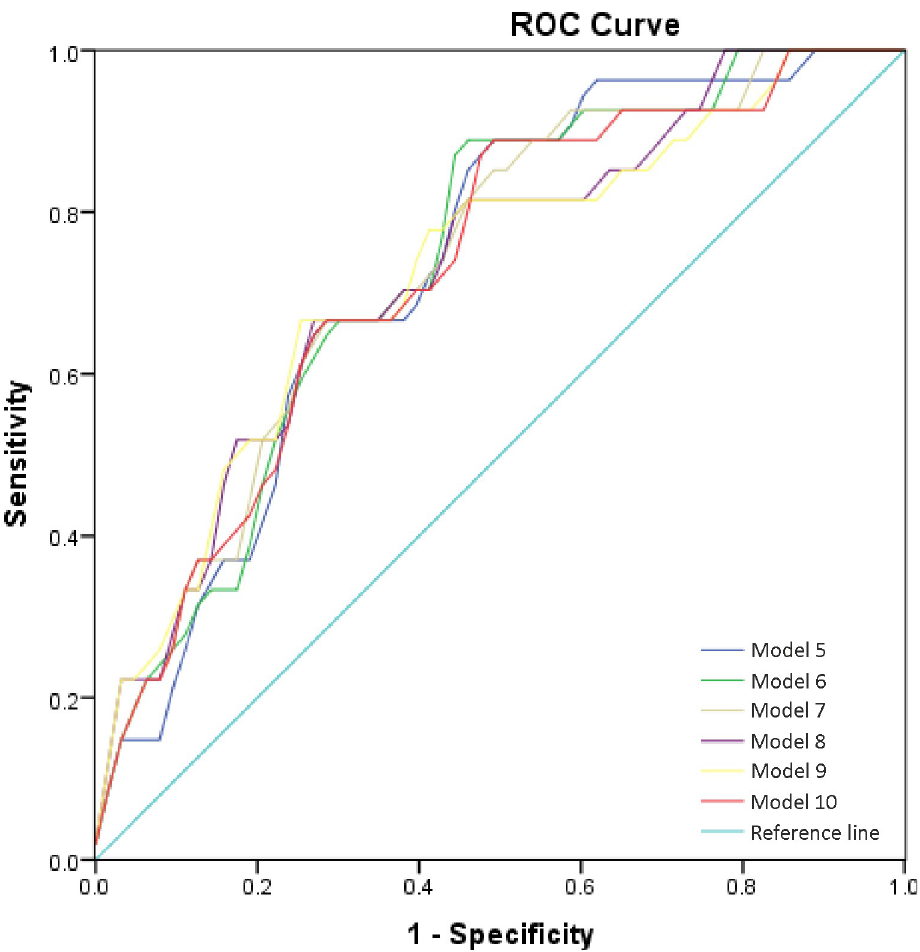
Fig 4. Receiver operating characteristics (ROC) curves for different models calculated from the logistic regression with best AUC. Abbreviations: AUC: Area Under the Curve; ROC: Receiver Operating Characteristic; The Models 11–13 as represented in Table